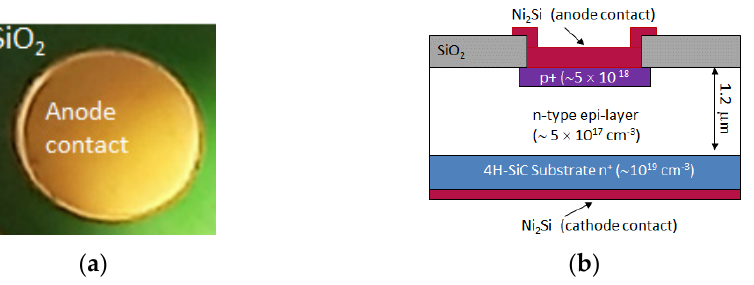
Figure 1. Top view picture of one diode: the circular anode contact is observable surrounded by a silicon dioxide layer ( a ); cross section scheme of fabricated devices (not to scale) ( b ).